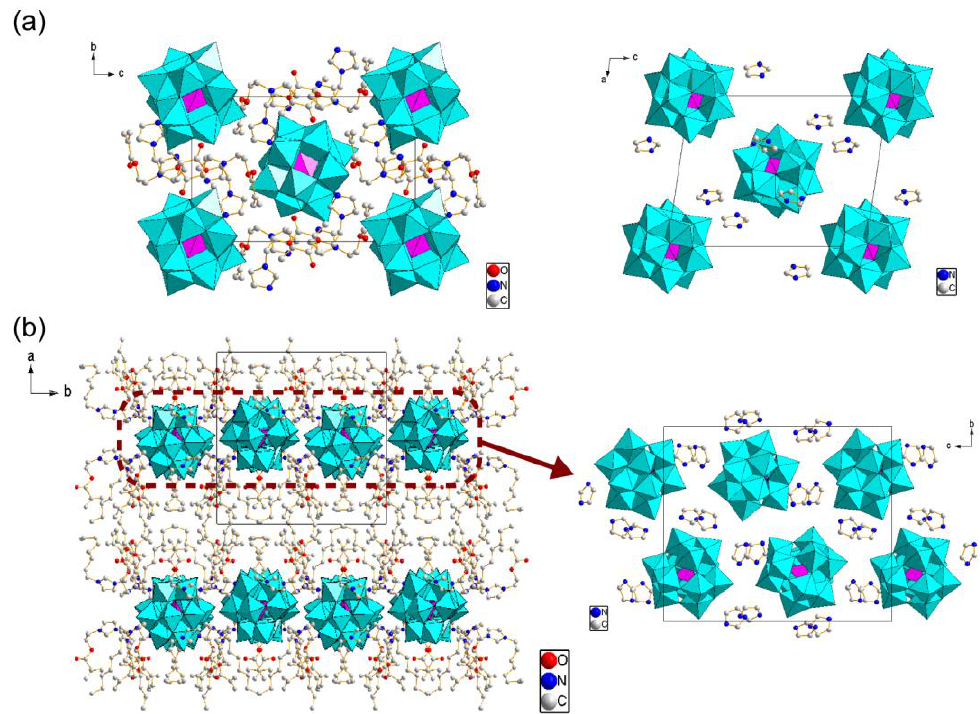
Figure 6. Crystal structures of SiW 12 hybrid crystals (C: gray, N: blue, O: red). SiW 12 anions are represented by polyhedrons. H atoms are omitted for clarity; ( a ) packing diagram of 3 (left, along a axis) and molecular arrangement of SiW 12 anions in 3 (right, along b axis); ( b ) packing diagram of 4 (left, along c axis) and molecular arrangement of SiW 12 anions in 4 (right, along a axis).